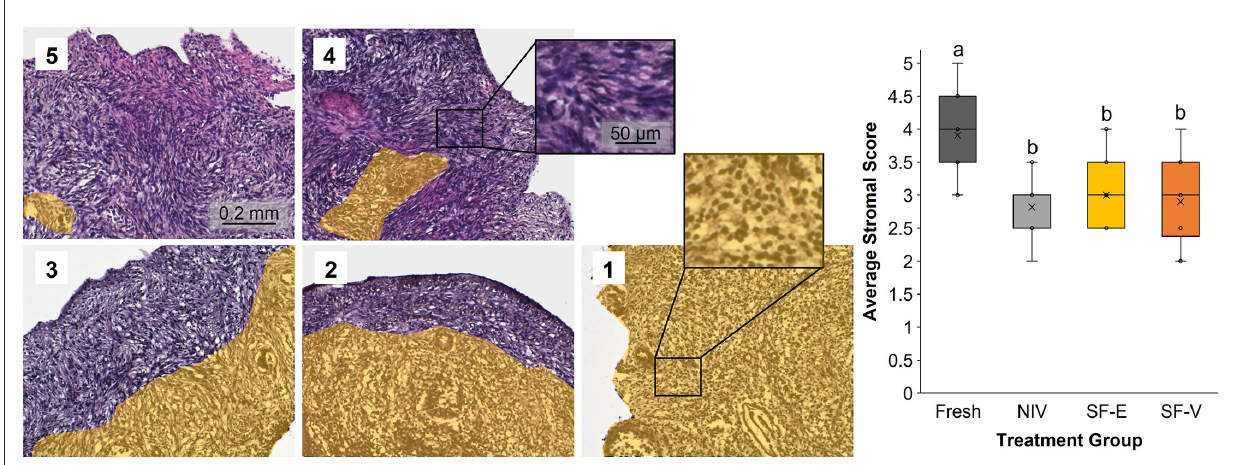
FIGURE3 Stromal cell integrity in Fresh vs. post-thawed African painted dog ovarian tissues cryopreserved with needle immersed vitrification (NIV), or slow freezing with either 7.5% DMSO and EG (SF-E), or 15% DMSO and EG with 0.5M sucrose (SF-V), with representative images of the scoring system (1-5) containing yellow overlay identifying areas with contiguous stromal cell disruption or atresia. Box-and-whisker plot display median, quartile, and data range, with letters indicating statistically significant differences among treatment groups following linear mixed model and post hoc Tukey’s HSD test ( p < 0.05).